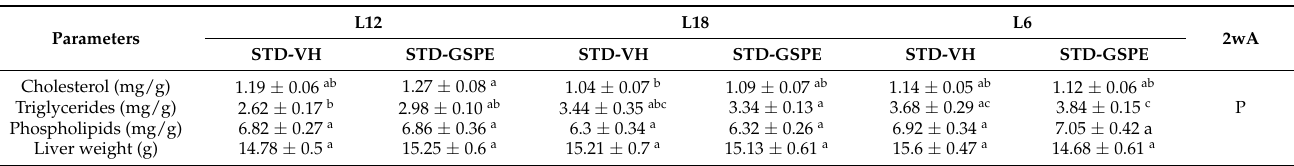
Table 3. Liver lipids parameters in response to different photoperiod exposure and GSPE treatment in animals fed a STD for 9 weeks.